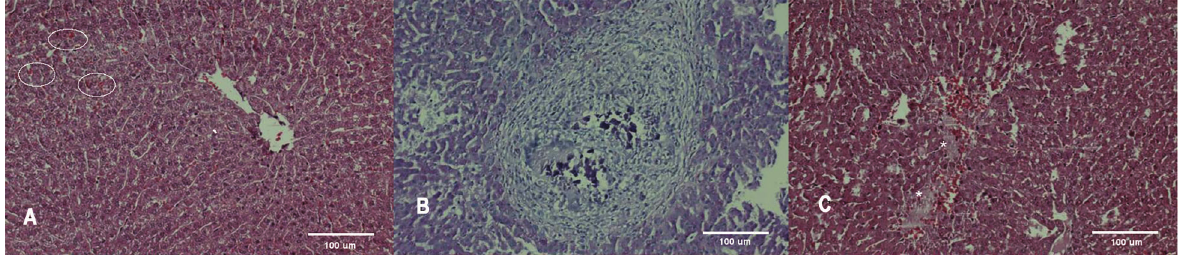
Figure 2. A , Microhemorrhage (circled in white) (hematoxylin and eosin). B , Myelin fi gures in the central part of the image indicating necrosis (periodic acid-Schiff staining). C , Micronecrosis (hematoxylin and eosin) in liver tissue of prostaglandin E1-treated rabbits (marked with asterisks).